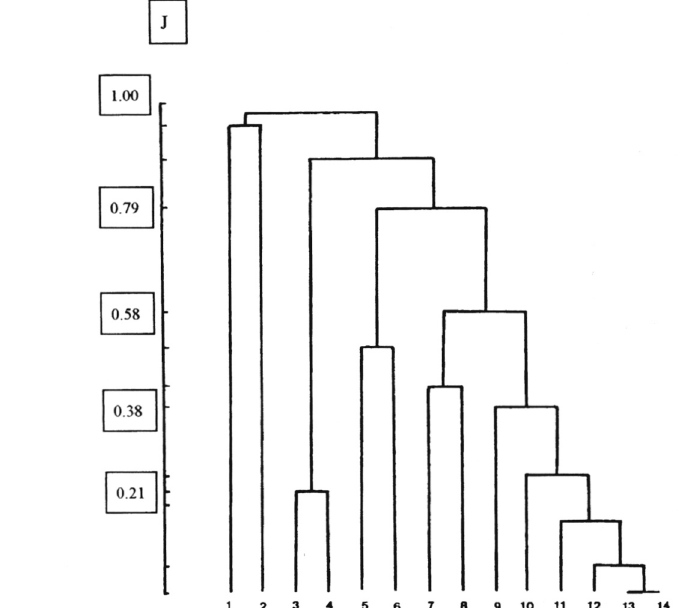
Fig. 1. - Cluster analysis according to species and geographical popu­ lations. Dendrogram constructed using Jaccard’s similarity index and clustering by average linkage. Number of observations = 153 (DNA fragments, data not shown), number of variables = 14 (popu­ lations). 1 is P. papatasi , 2 is P. sergenti, 3 is P. ariasi from sou­ theastern Spain, 4 is P. ariasi from southwestern Spain, 5 is P.